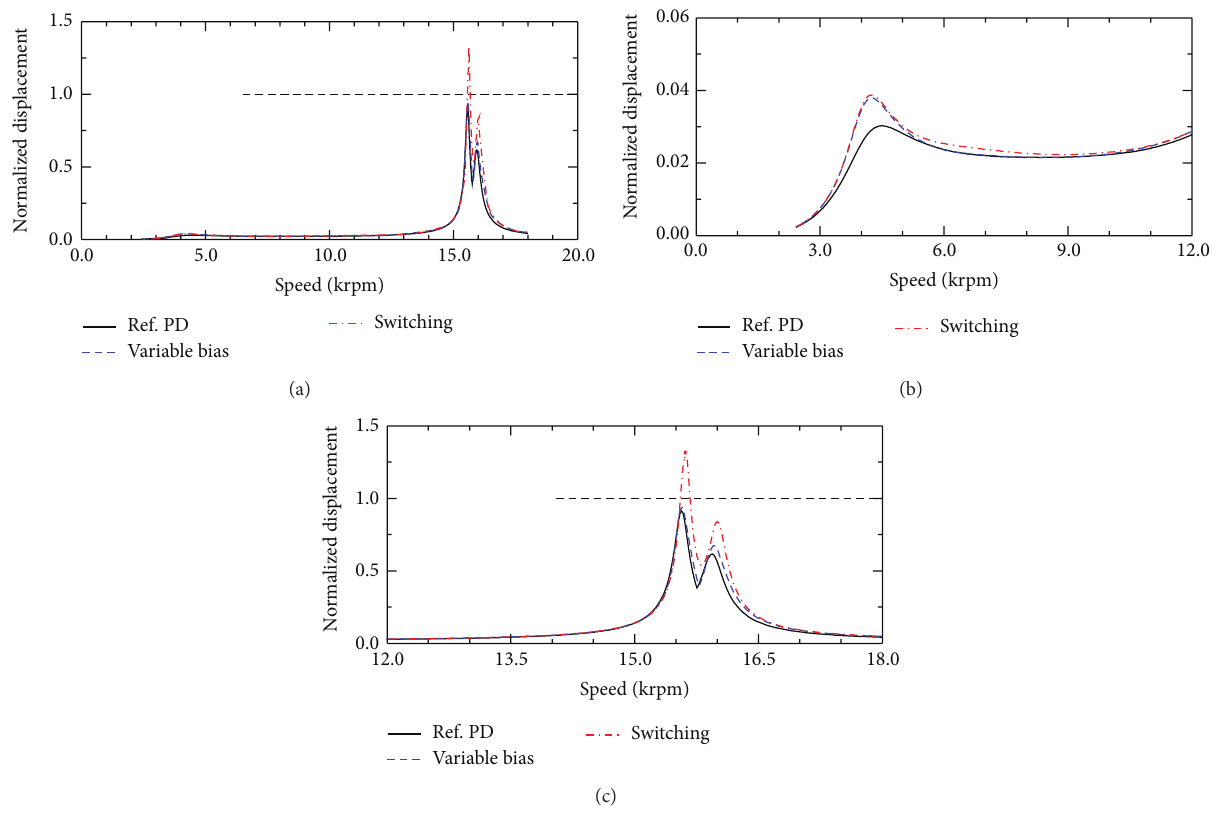
Figure 9: Unbalance response